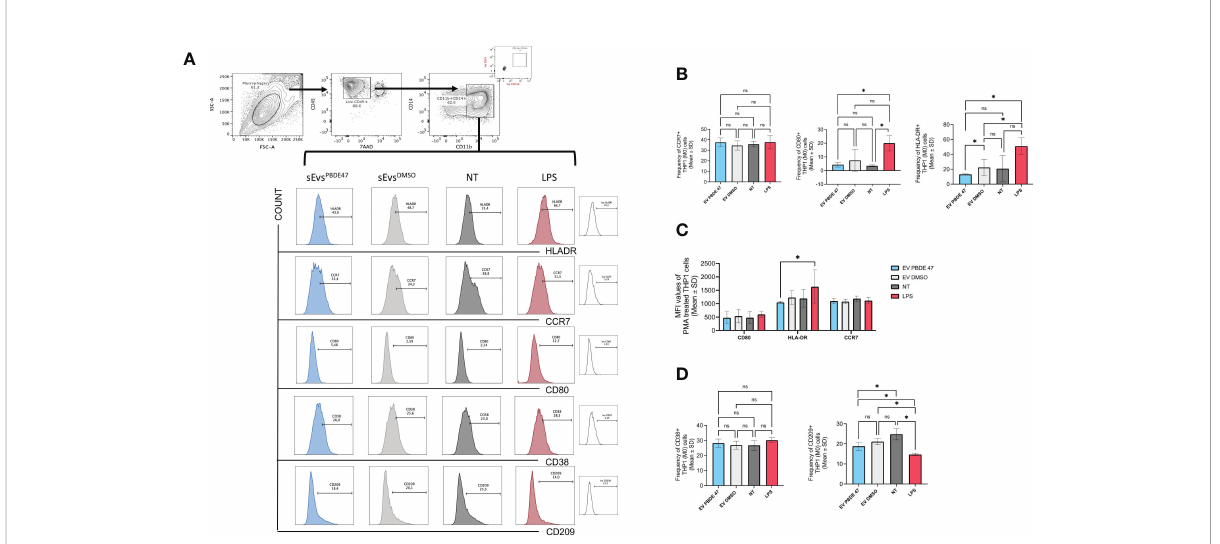
FIGURE 5 Immuno-characterization of M(0) THP-1 macrophage-like treated with sEVs PBDE+LPS Macrophage sEVs PBDE+LPS on resting M(0) THP-1 macrophage-like affecting expression of surface markers of macrophage polarization by fl ow cytometry analysis. (A) gating strategy analyzing the selected macrophage population for CD14/CD11b expression in each experimental condition. (B) Cumulative analysis of resting M(0) THP-1 macrophage-like treated with macrophage sEVs PBDE+LPS , or sEVs PBDE+LPS , indicated percentage of the CD14/CD11b cells expressing CCR7, CD80 and HLA-DR. Untreated cells (NT) and LPS were considered as experimental control condition. (C) Cumulative analysis of the Mean Fluorescence Intensity (MFI) of resting M(0) THP-1 macrophage-like treated with macrophage sEVs PBDE+LPS expressing CCR7, CD80 and HLA- DR. (D) Cumulative analysis of resting M(0) THP-1 macrophage-like treated with macrophage sEVs PBDE+LPS , or only DMSO, indicated percentage of the CD14/CD11b cells expressing CD38 and CD209. Untreated cells (NT) and LPS were considered as experimental control condition. Non statistical signi fi cance is indicated as ns. *P ≤ 0.05 by nonparametric Mann-Whitney test, unpaired and one-tailed with con fi dential interval